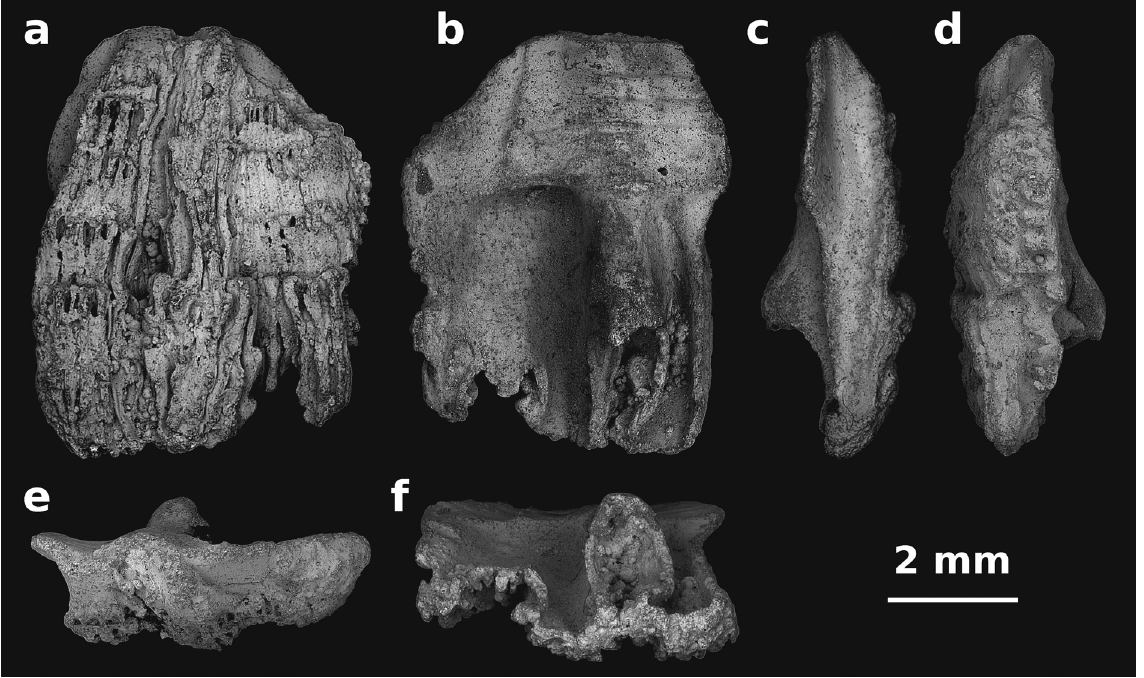
Fig. 2. † Platylepas mediterranea sp. nov., holotype, single right carinolateral compartment (CL1 or CL2) collected at Cala S. Antonino (Cape Milazzo, Sicily, southern Italy) from Lower Pleistocene (Gelasian) deposits (MSNC 4562). a . Outer view. b . Inner view. c . Alar view. d . Radial view. e . Apical view. f . Basal